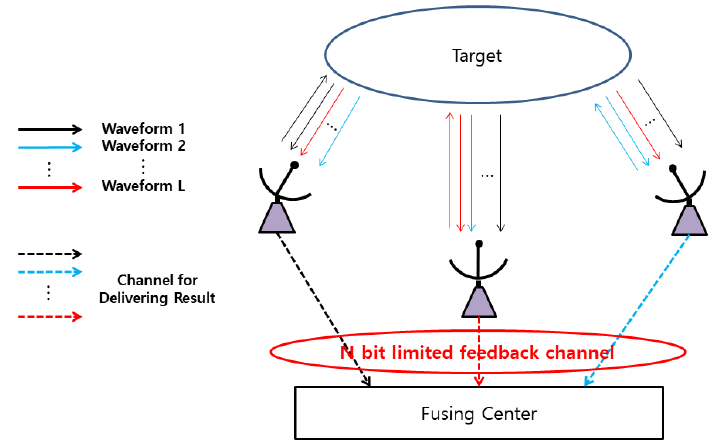
Figure 1. Model of a distributed micro-Doppler radar